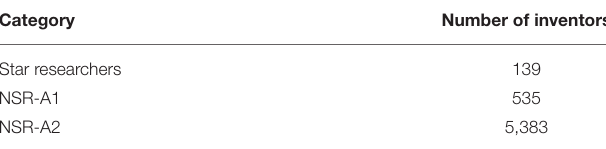
TABLE 1 | Classification of study